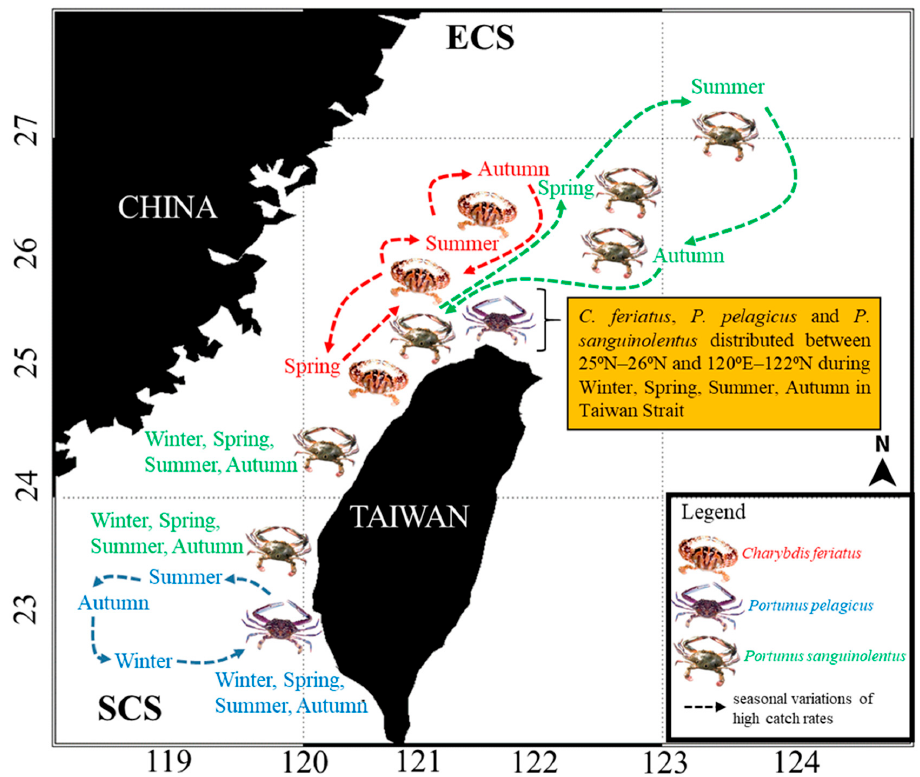
Figure 7. Illustration of the seasonal spatial distribution variations in high catch rates of C. feriatus, P. pelagicus, and P. sanguinolentus in the